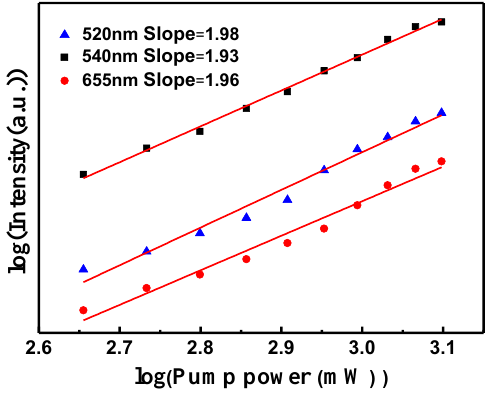
Figure 9. Pump power dependence of the fluorescent bands centered at 520, 540, and